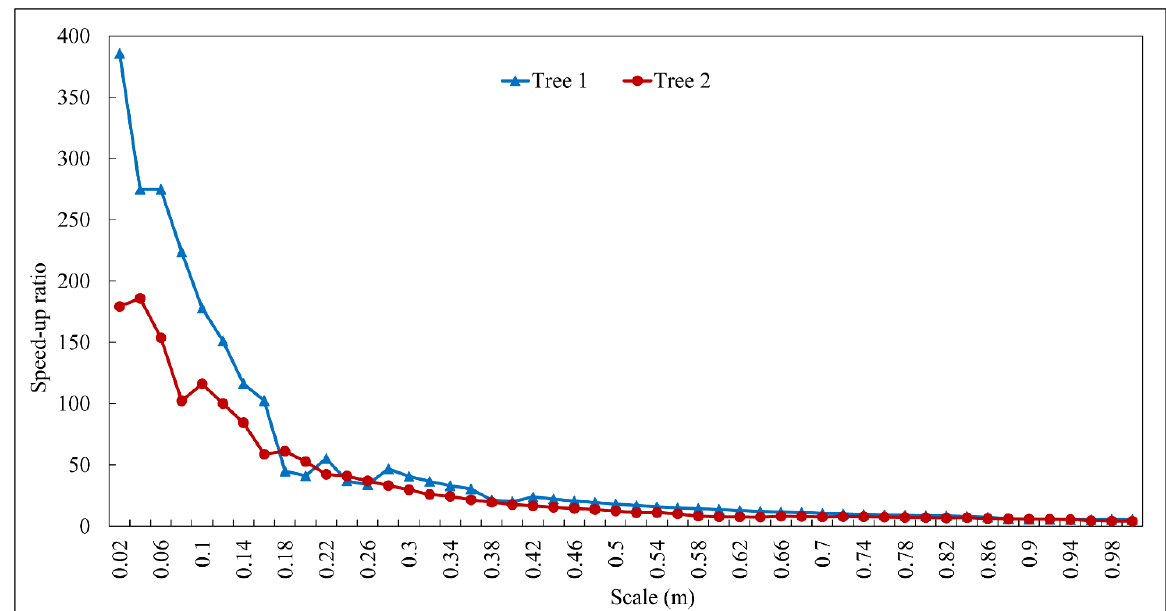
Figure 4. The speed-up ratio of each single-scale classifier over multi-scale classifier for each